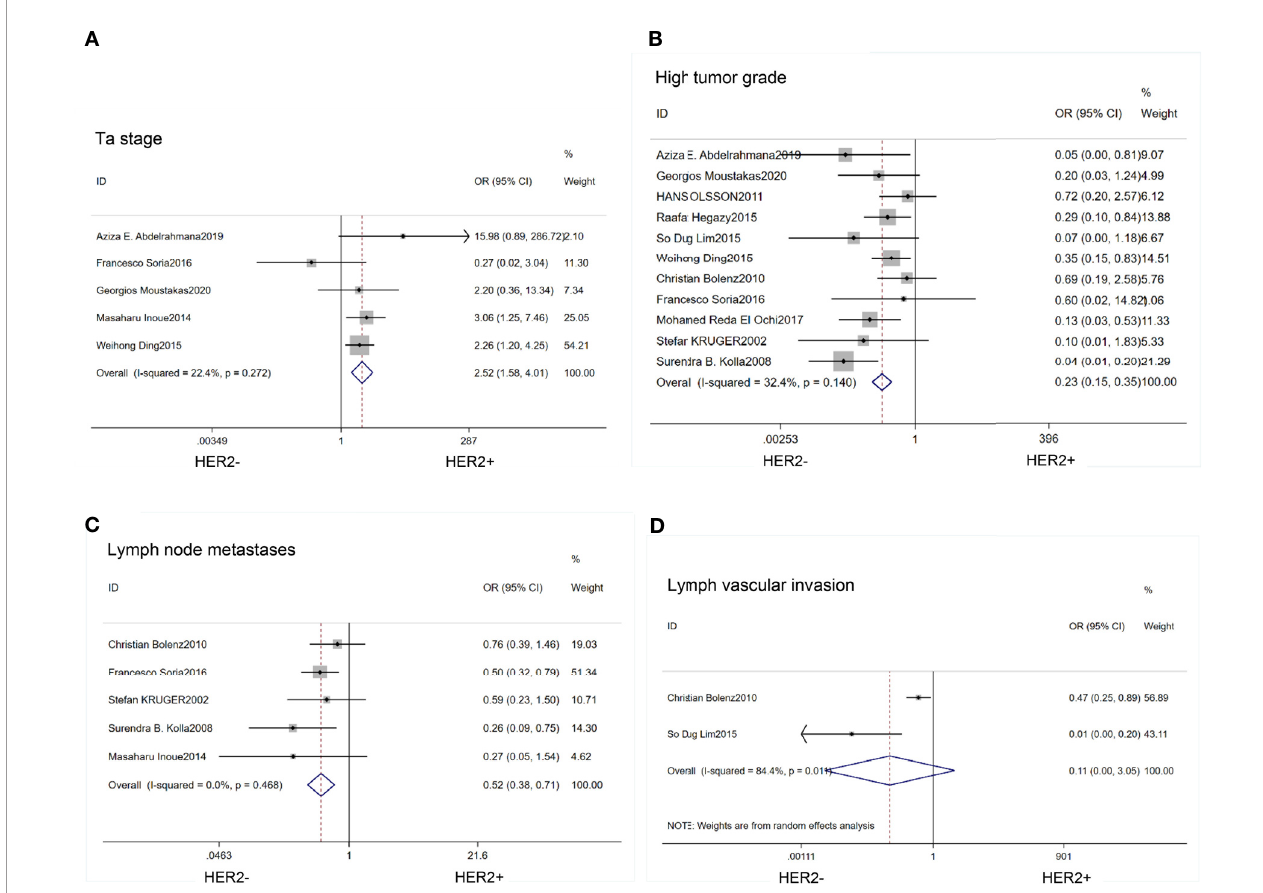
FIGURE 3 | Forest plots describing the correction of HER2 protein expression with stage (A) , grade (B) , lymph node metastases (C) and lymph vascular invasion (D) . OR, odds ratio; CI, con fi dence